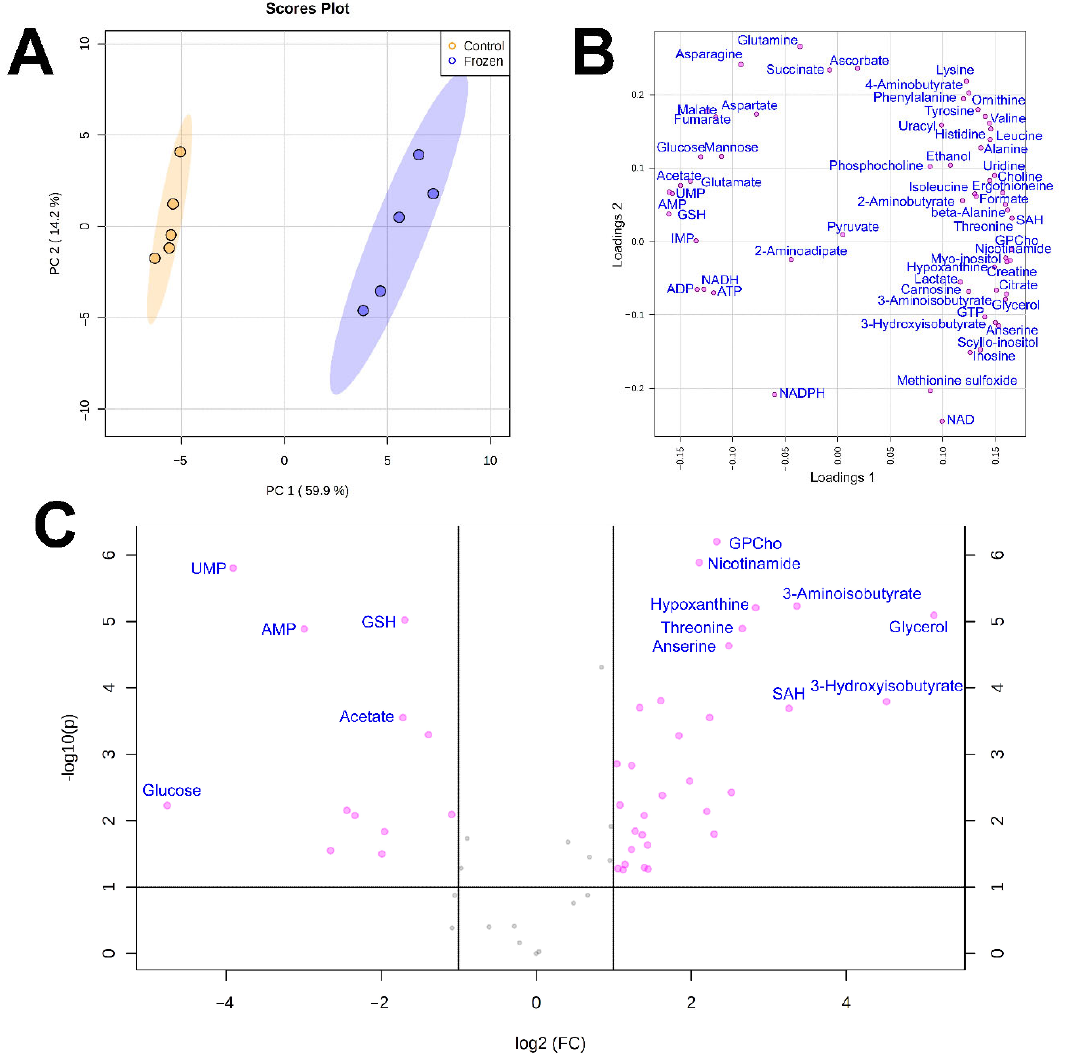
Figure 1. ( A ) Scores plot of the principal component analysis (PCA) of liver metabolomic profiles of frozen (blue) and control (yellow) individuals of S. keyserlingii . The data are range scaled. Colored ovals indicate 95% confidence regions. Variance explained by the first (PC1) and second (PC2) principal components is indicated on the axis of scores plot. ( B ) Loadings plot for the same data. ( C ) Volcano plot for frozen and control liver samples.